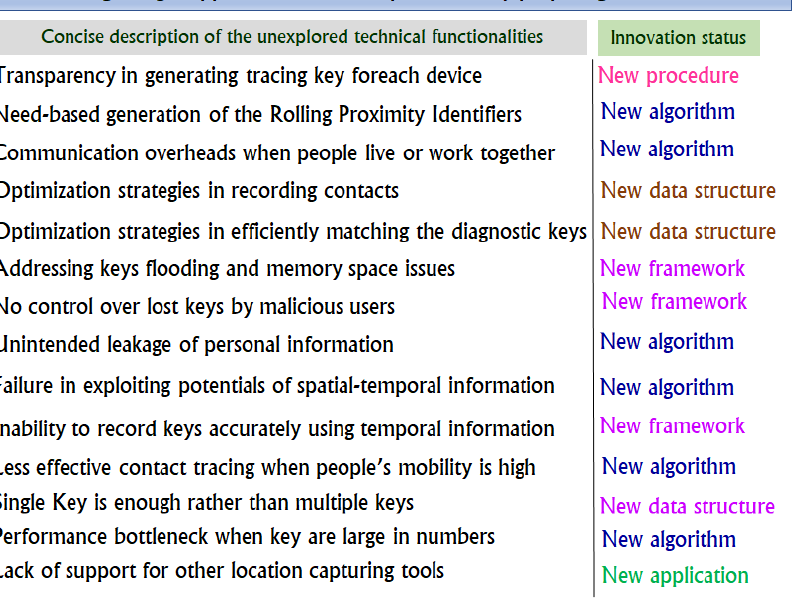
Figure 9. Overview of new functionalities in the form of data structure, algorithm, and applications in the Apple Google CT